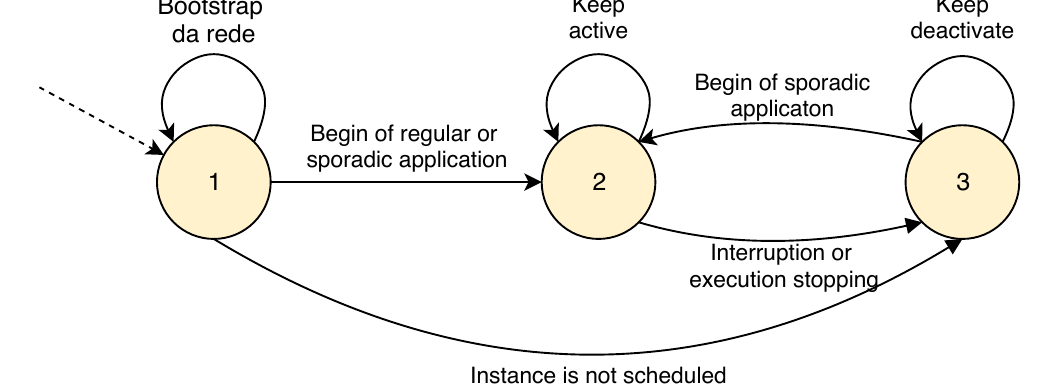
Figure 5. State diagram for instances